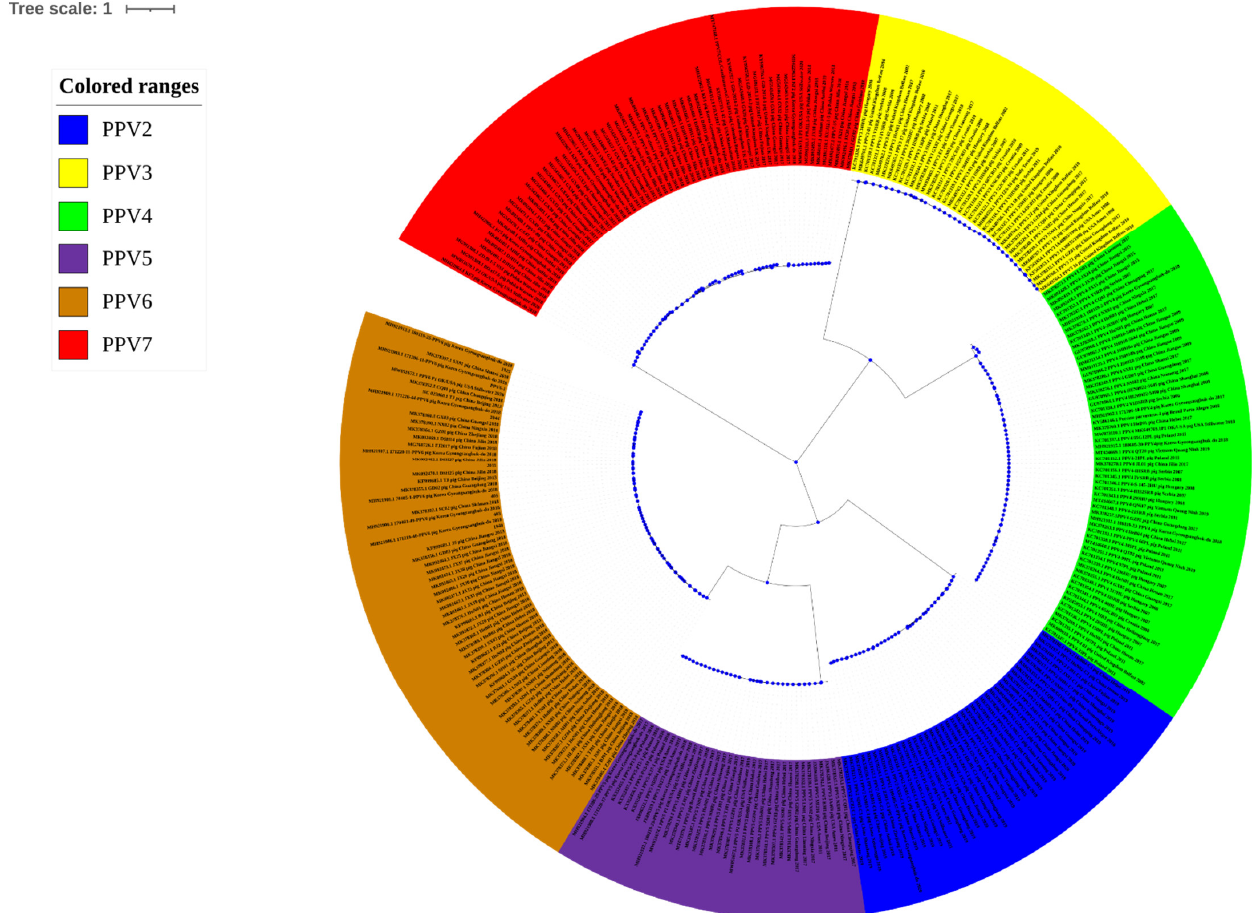
Figure 1. PPV phylogenetic tree based on the nucleotide sequence of all PPV sub-types.